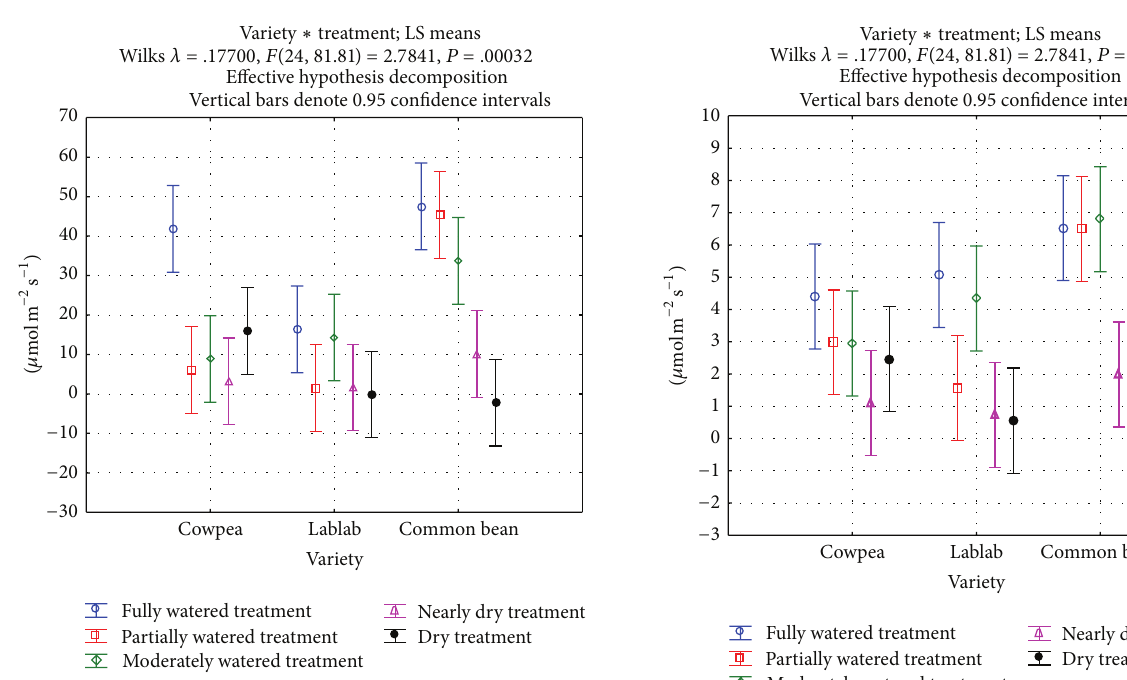
Figure 16: Stomatal conductance on 55